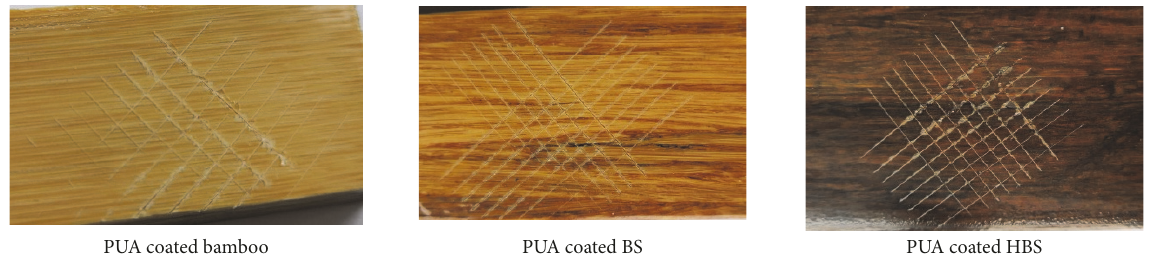
Figure 7: Images of coated samples after cross-cut